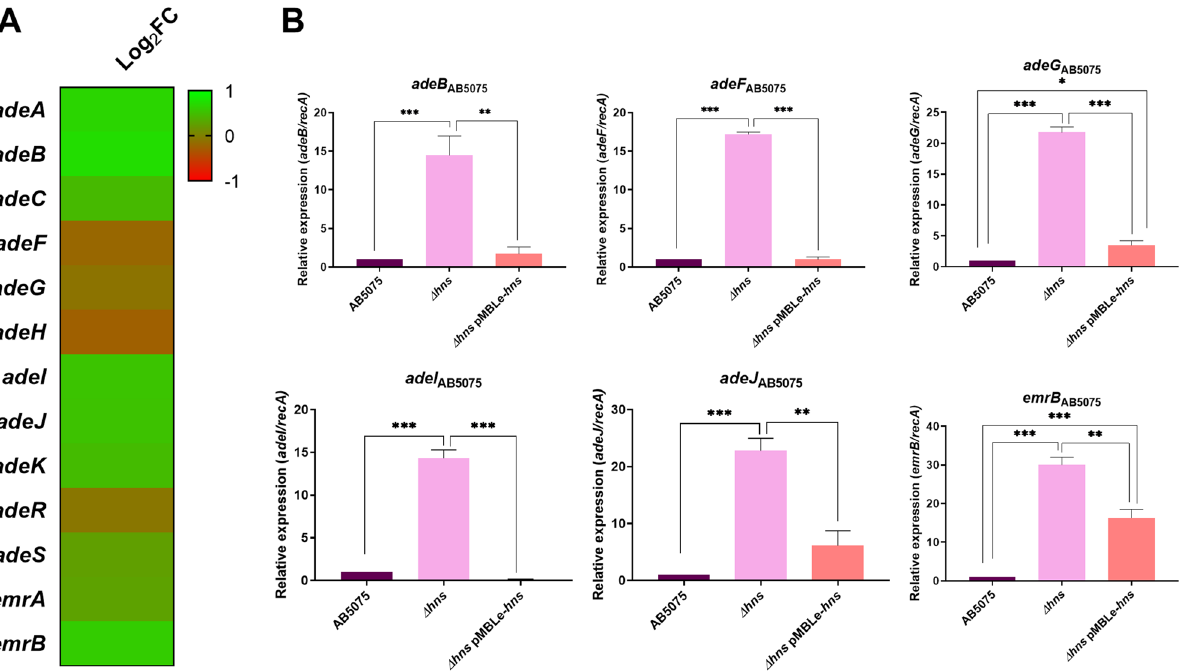
Figure 2. Genetic analysis of efflux pumps coding genes. ( A ) Heatmap outlining the differential expression of genes associated with efflux pumps in A. baumannii AB5075 Δhns vs. parental strain. The asterisks represent the DEGs (adjusted P -value < 0.05 with log2fold change > 1). Heat map was performed using GraphPad Prism version number 9 (GraphPad software, San Diego, CA, USA, https:// www. graph pad. com/). ( B ) qRT-PCR of AB5075, AB5075 Δhns and AB5075 Δhns pMBLe- hns strains genes associated with efflux pumps, the expression levels and the fold changes were determinate using the double ΔCt analysis. At least three independent samples were used, and three technical replicates were performed from each sample. Statistical significance ( P -value < 0.05) was determined by ANOVA followed by Tukey’s multiple comparison test; one asterisks: P -value < 0.05; two asterisks: P -value < 0.01 and three asterisks: P -value < 0.001. This figure was performed using GraphPad Prism version number 9 (GraphPad software, San Diego, CA, USA, https:// www. graph pad.